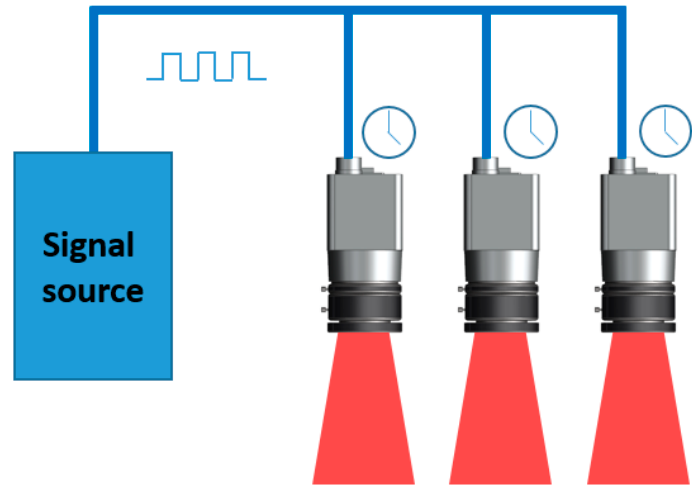
Figure 5. Schematic diagram of synchronous acquisition of TSV.